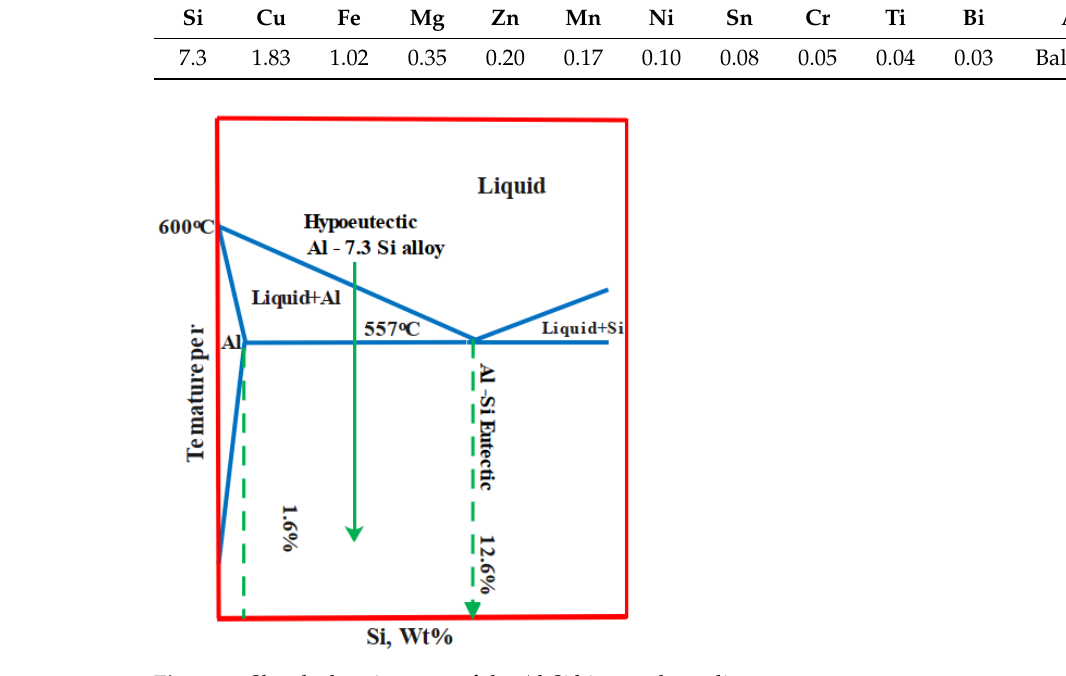
Figure 2. Sketch showing part of the Al-Si binary phase diagram.